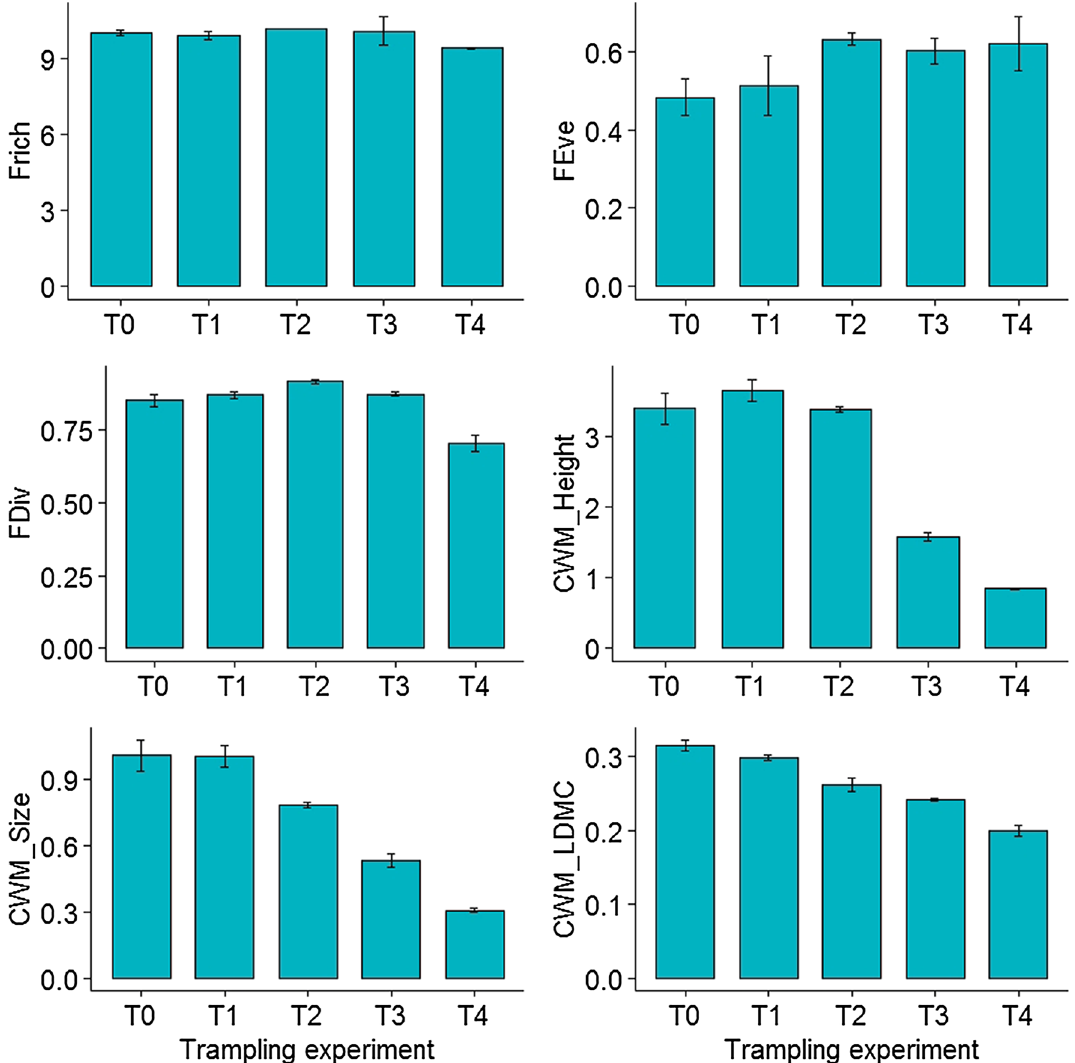
Figure 2. Effects of trampling disturbance on multivariate functional diversity metrics and community- weighted mean (CWM) trait values of grassland communities. Functional richness (FRich), functional evenness (FEve) and functional divergence (FDiv) is used to represent multivariate functional diversity, and CWM values of plant height (PH), leaf area (LA) and leaf dry matter content (LDMC) are quantified. T 0 , T 1 , T 2 , T 3 , T 4 and T 5 represents experimental lanes receiving 0, 25, 75, 250 and 500 trampling passes,